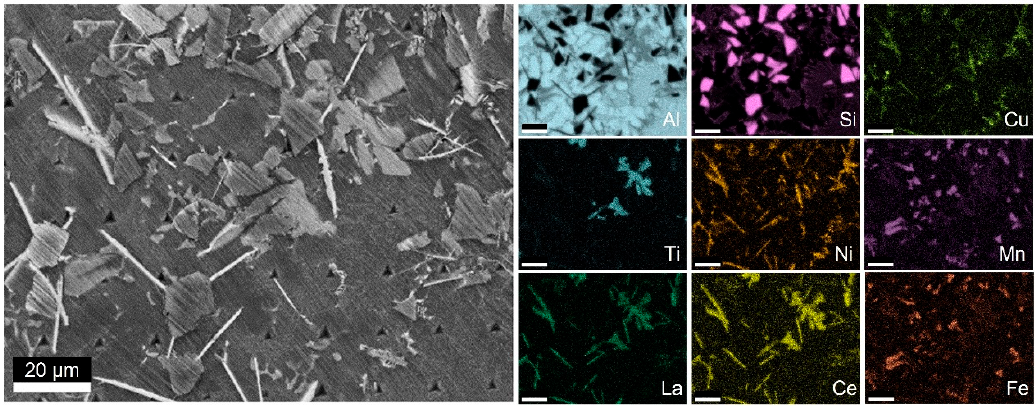
Figure 2. SEM image and EDS mapping: Material C1.